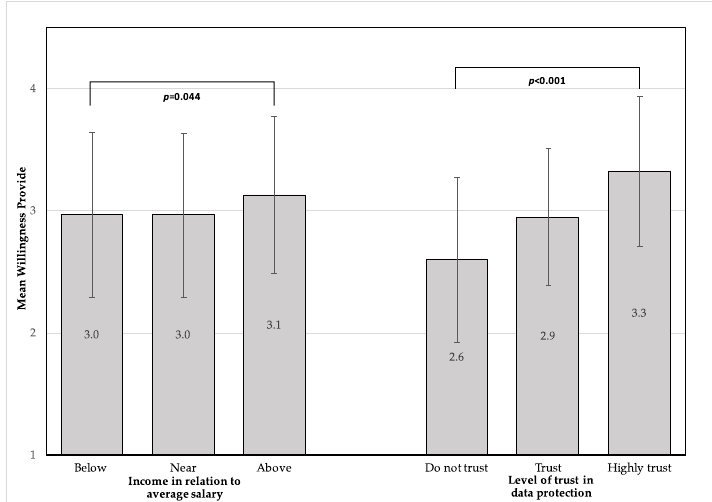
Figure 2. Differences in mean willingness to provide medical information through remote communications in times of emergencies. Error bars represent standard deviation.